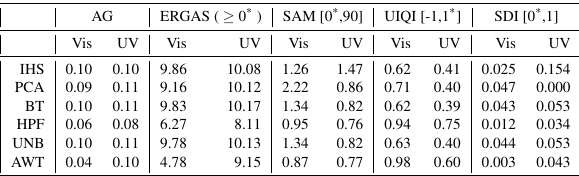
Table 3: Ina D: Average values of performance metrics